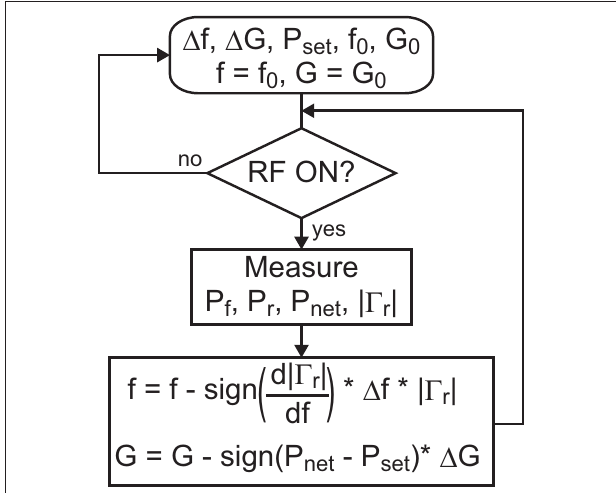
FIGURE 6 | Flow chart of the automatic, fast, and autonomous control of the rf system. 1 f , 1 G , P set , f 0 , and G 0 are the variation step of the frequency, the variation step of the gain of the VVA, the target value of the net rf power, the initial frequency, and the initial gain of the VVA,